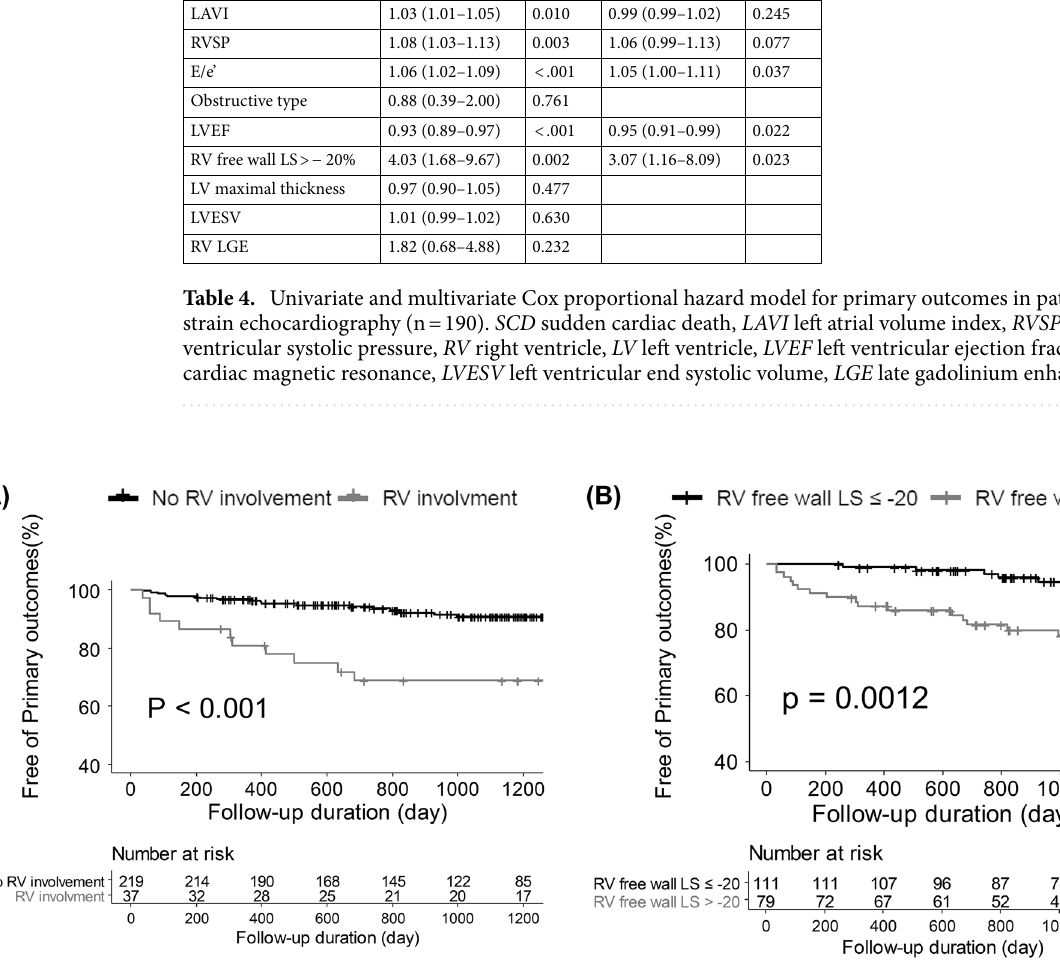
Figure 2. Kaplan–Meier curves for primary outcome-free survival (A) according to the presence of right ventricular involvement and (B) according to the presence of impaired right ventricular free wall longitudinal